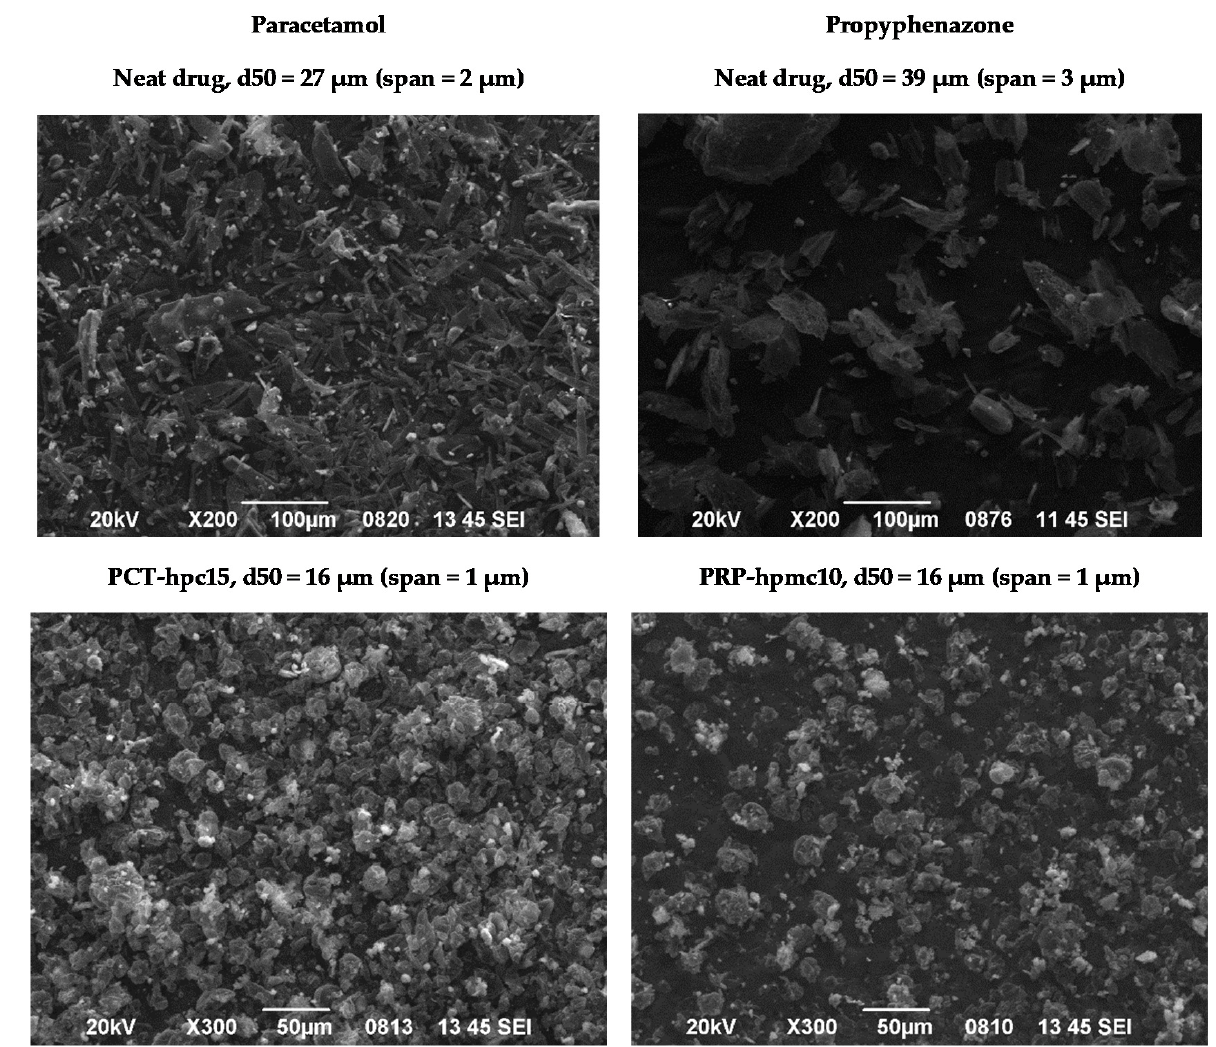
Figure 7. SEM microphotographs of neat drugs and optimal co-spray dried batches of paracetamol with 15% HPC (PCT- hpc15) and propyphenazone with 10% HPMC (PRP-hpmc10). (PCT-hpc15) and propyphenazone with 10% HPMC